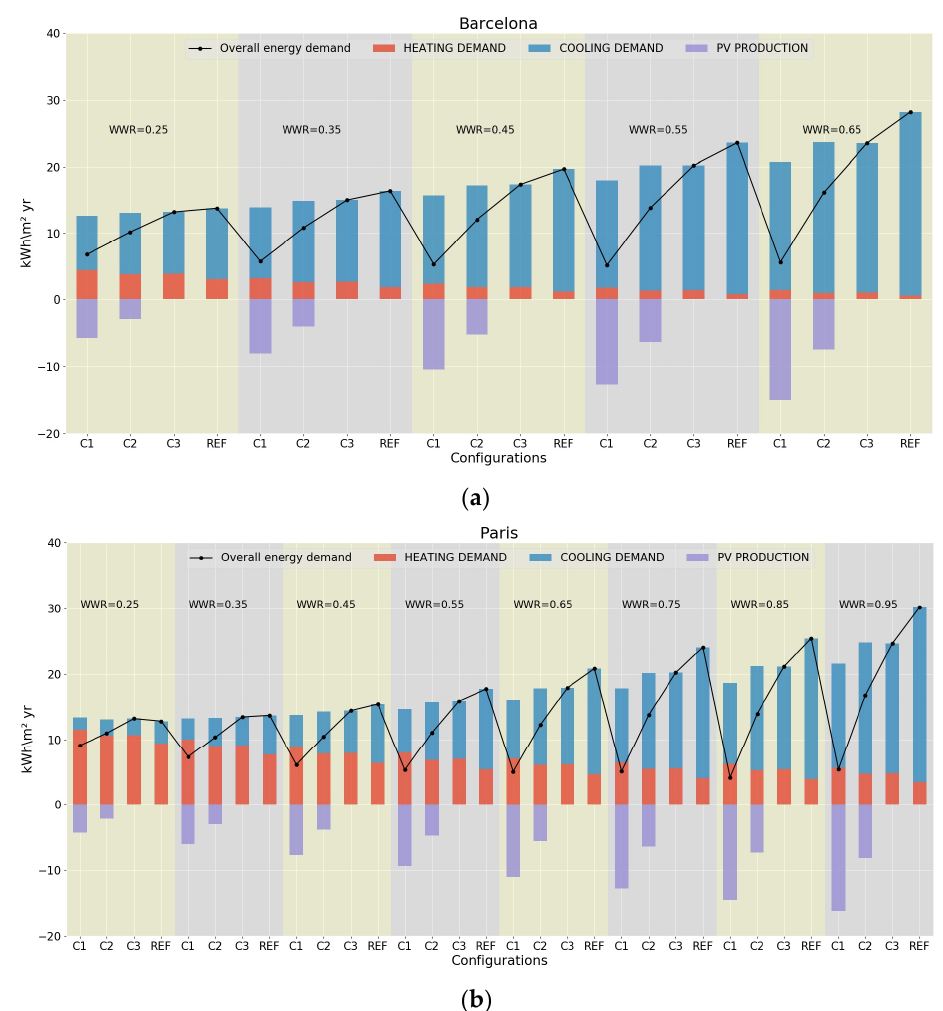
Figure 7. Annual consumption of different configurations: ( a ) Barcelona; ( b ) Paris.